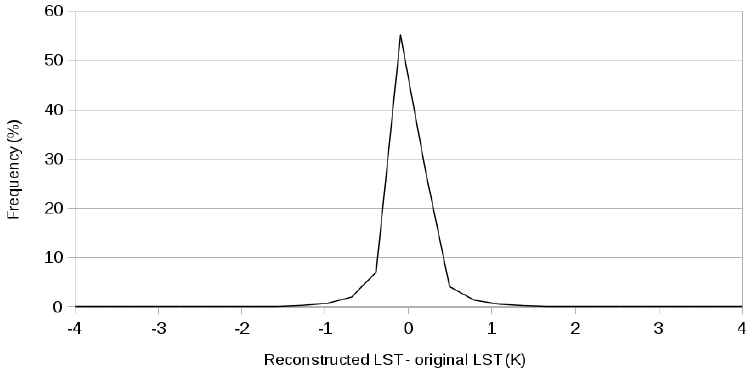
Figure 5. Validation of the LST reconstruction method. The histogram shows the difference between the reconstructed and the original MODIS LST values for 1 January 2010, at 10:30 am local time ( cf . Figure 15 in Crosson et al.